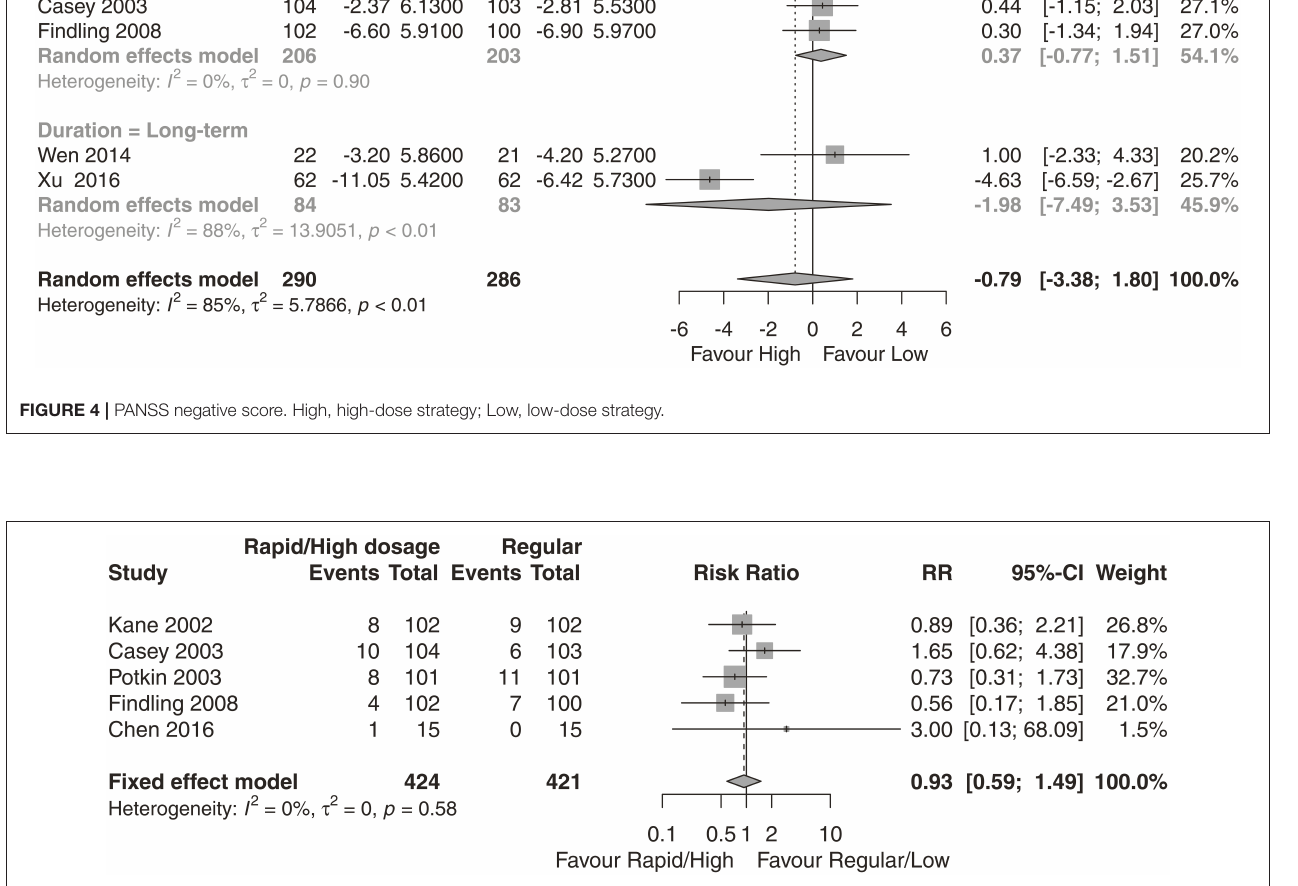
FIGURE 5 | Discontinuation due to adverse events (DAEs).